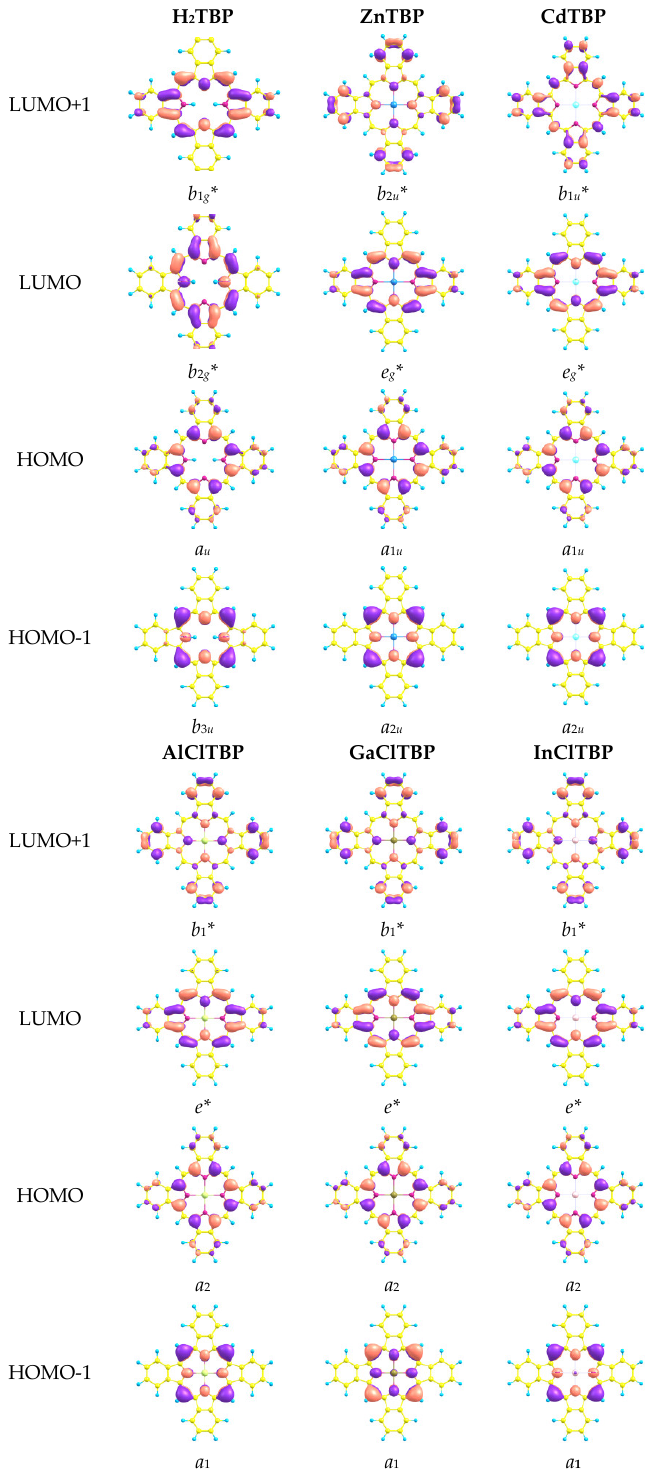
Figure 5. Shapes of the frontier molecular